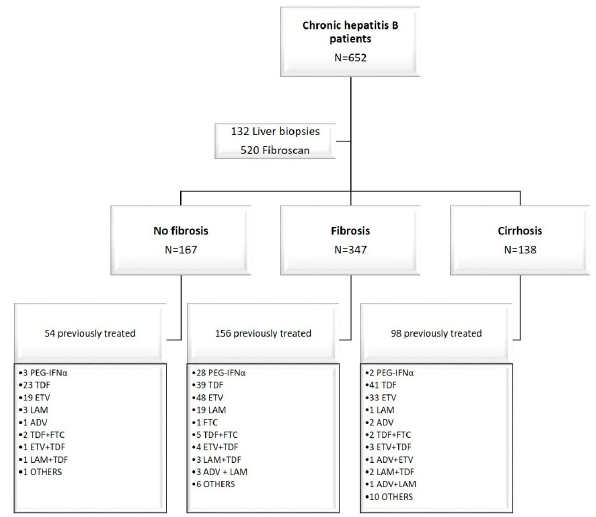
Figure 1. Disposition of enrolled patients. The liver assessment was performed at the time of enrollment in the study, and the treatment history was provided simultaneously. The median of treatment before the liver fibrosis assessment was 3 months. PEG-IFN α , pegylated interferon alfa; TDF, tenofovir;